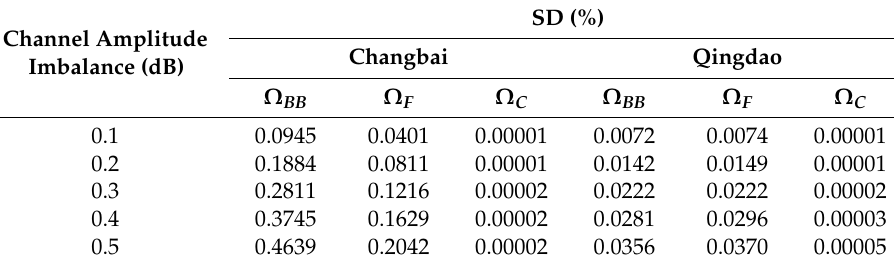
Table 9. SD ( σ SD ) under the condition of channel amplitude